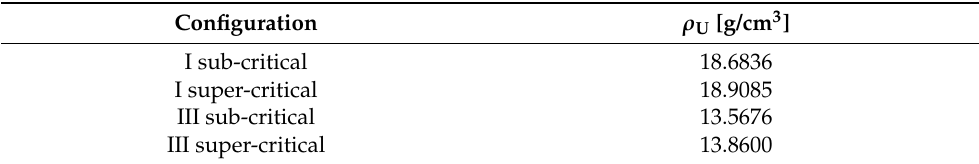
Table 1. Uranium densities for benchmark configurations. Uranium isotopic mass fractions and water properties are equal to those described in the reference [12].